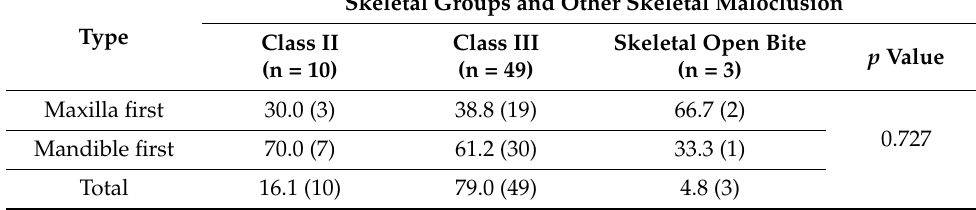
Table 7. The frequency of the order in which a particular osteotomy was performed in bimaxillary surgeries broken down into skeletal classes and skeletal open